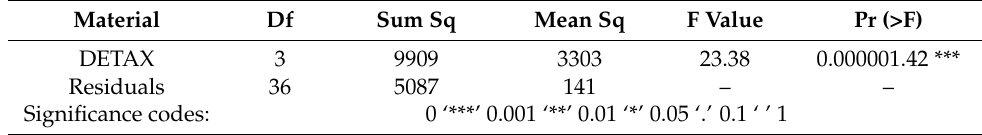
Table 6. ANOVA results of flexure strength for DETAX